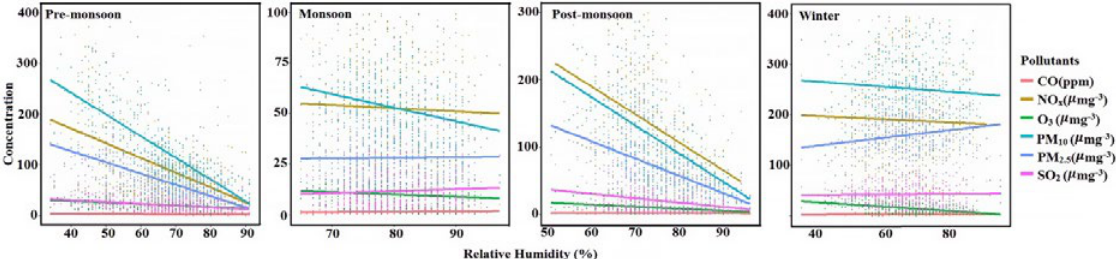
Fig. 6: Correlation between air pollutants concentration and seasonal relative humidity a) pre ‐ monsoon (March ‐ May) b) monsoon (June ‐ September) c) post ‐ monsoon (October ‐ November) and d) winter (December ‐ February)